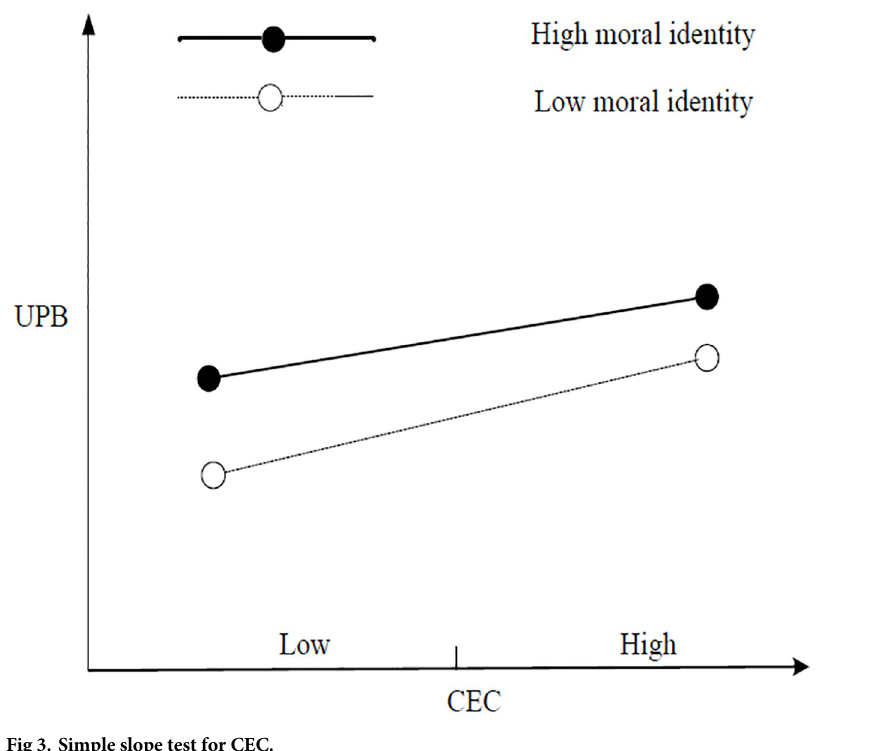
Fig 3. Simple slope test for CEC.